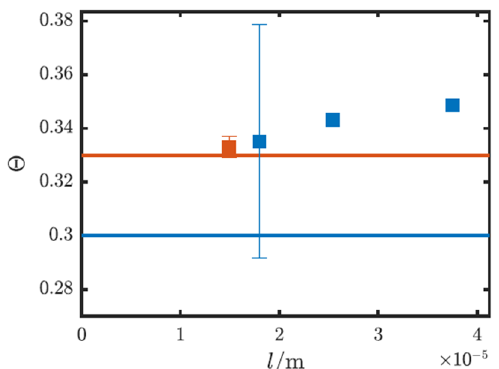
Figure 6. Results of the grid convergence study. Nondimensional temperature Θ versus grid length l . Solutions on coarse (